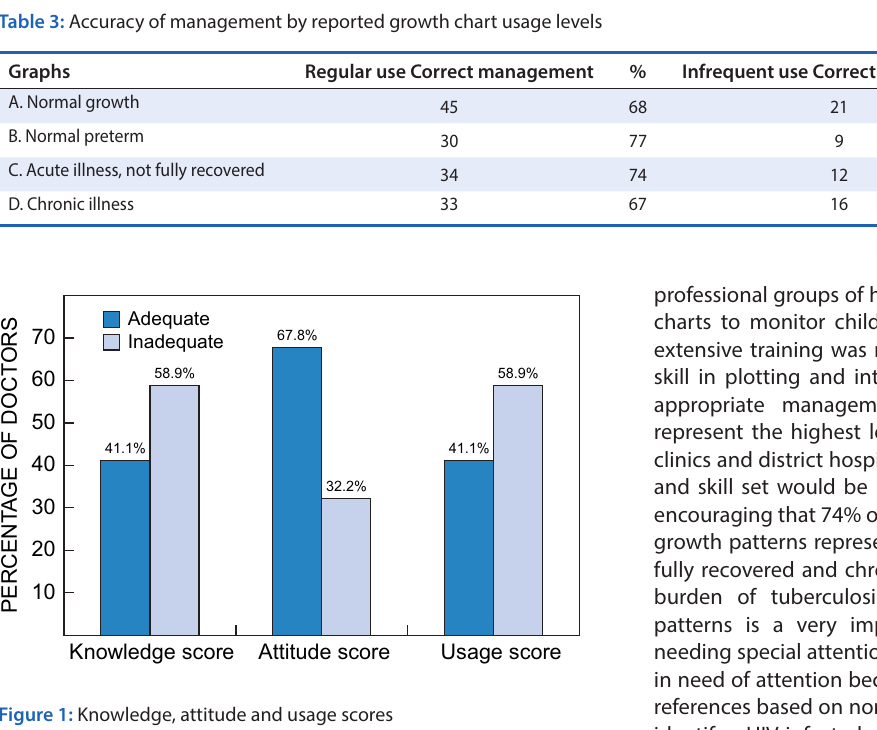
Figure 1: Knowledge, attitude and usage scores